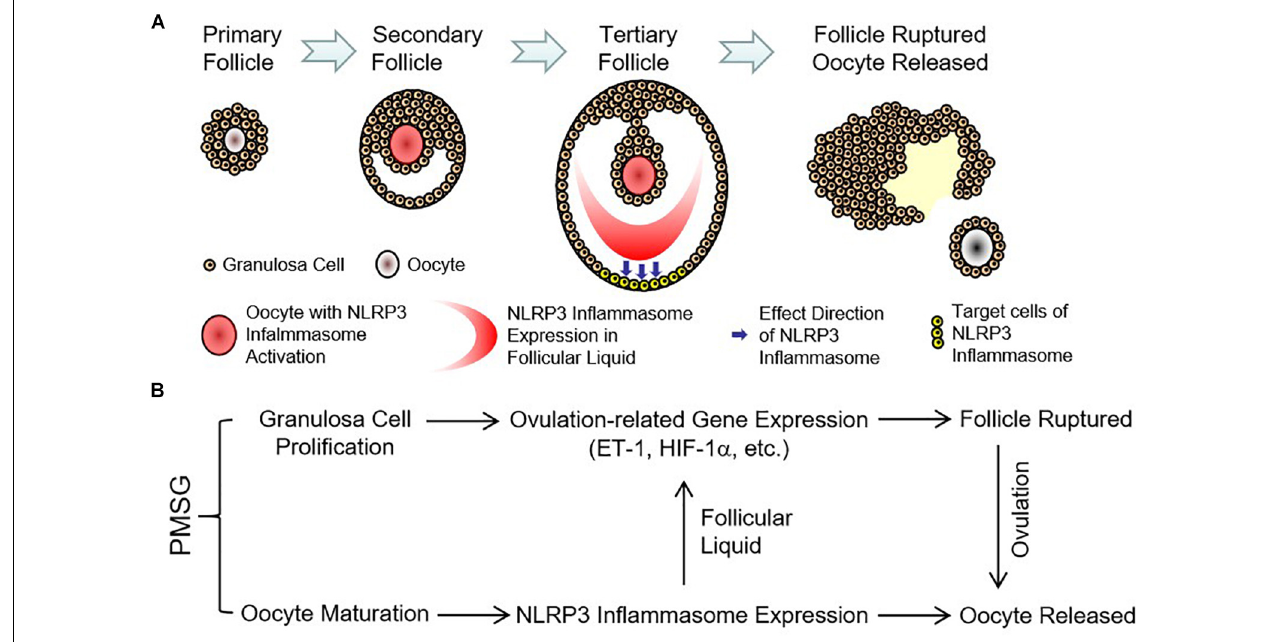
FIGURE 9 | Expression pattern and possible role of NLRP3 inflammasomes in the ovaries during the follicular development induced by PMSG. (A) Expression pattern of NLRP3 inflammasomes in the ovarian follicles during the follicular development induced by PMSG. (B) Possible role of NLRP3 inflammasomes in the PMSG-treated ovaries during the follicular development and the following